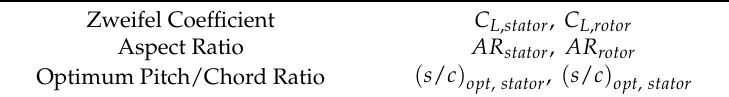
Table 2. Design parameters for blade geometry